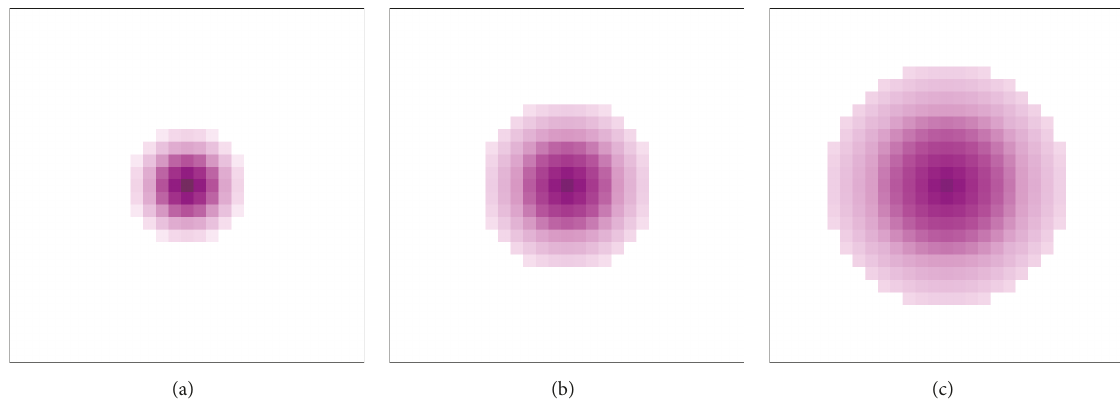
Figure 1: Different values for the decay 𝛿 of a repulsor: (a) with 𝜎 = √5 ; (b) with 𝜎 = √10 ; and with 𝜎 = √20 .